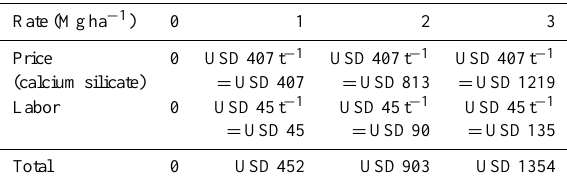
Table 1. Cost of calcium silicate applied to a 1ha area for rice pro-